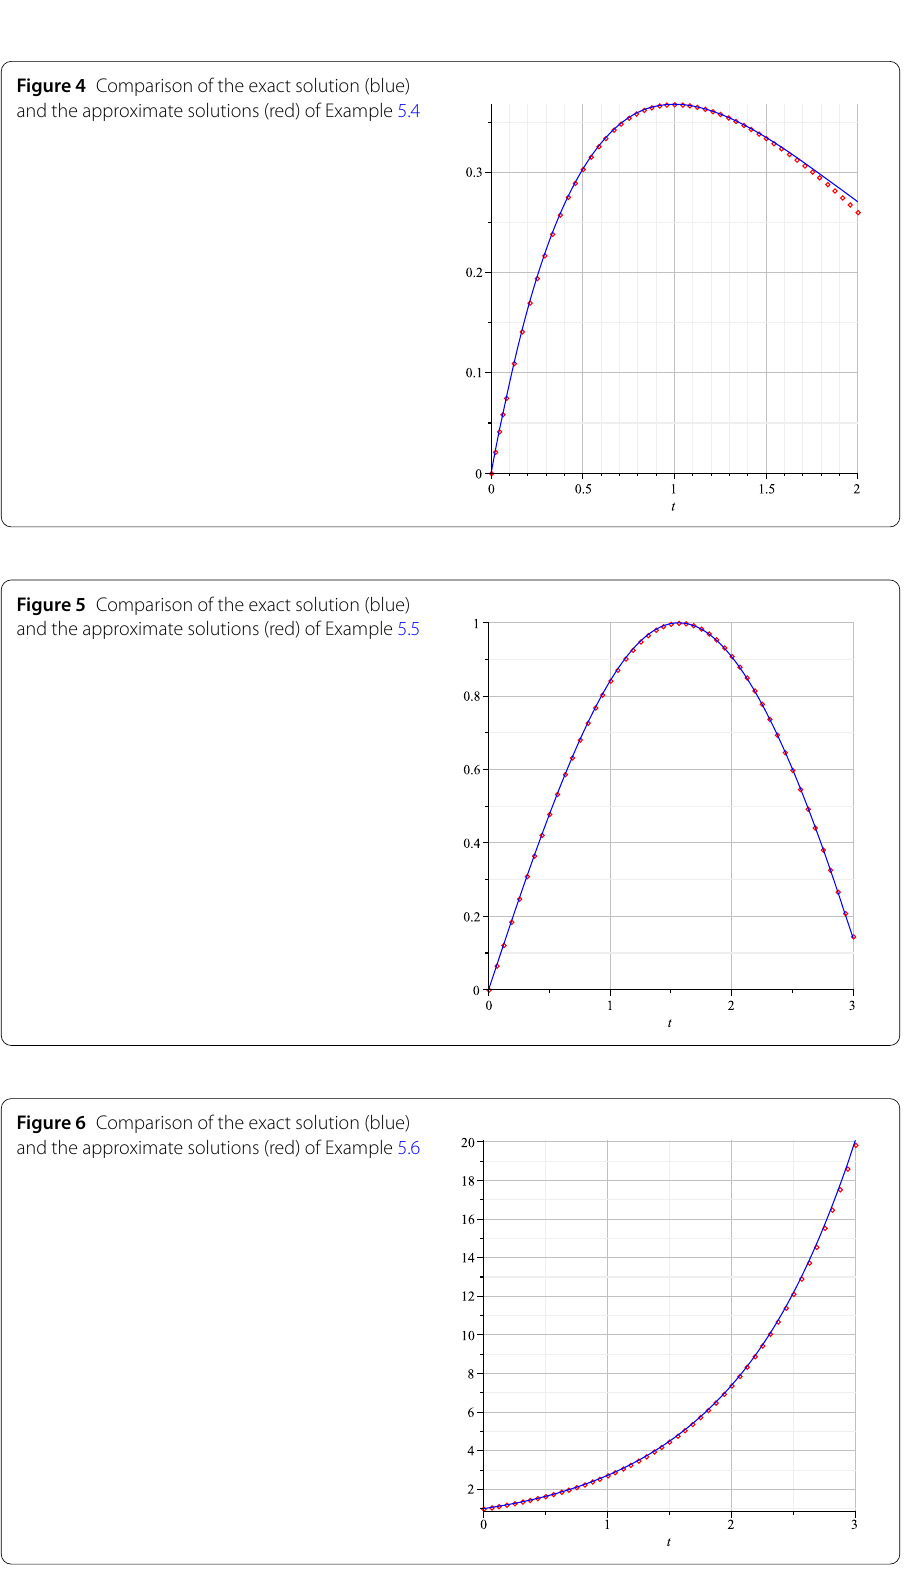
and powerful method over other methods for solving many linear and nonlinear panto- graph type of DEs and VIDEs with proportional delays arising in mathematical